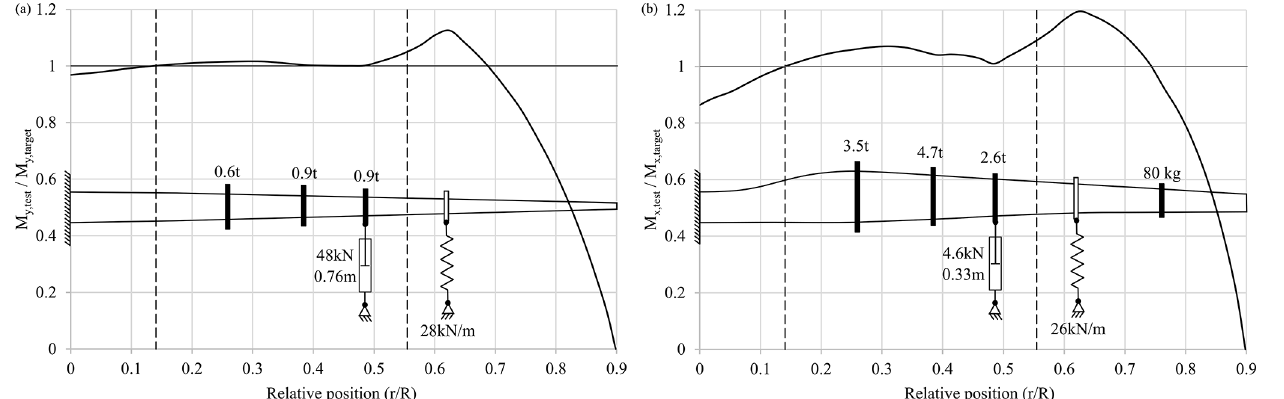
Figure 6. Schematic of setups with springs and test/target load ratio in flapwise (a) and lead-lag (b) directions.